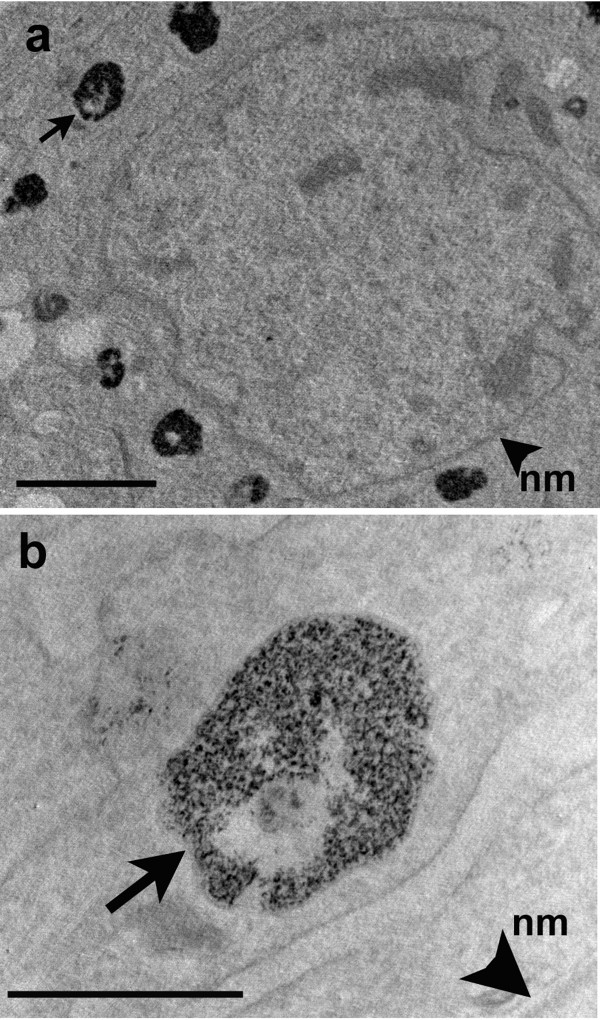
TEM of QD labeled MSC. a. Low magnification, representative image of MSC with QD nanocrystal aggregates in endosomal vesicles around nuclear membrane (nm, arrowhead). Scale bar 2 μm. b. High magnification of enlarged single vesicle (arrow, a and b) showing individual QDs. Scale bar 500 nm.